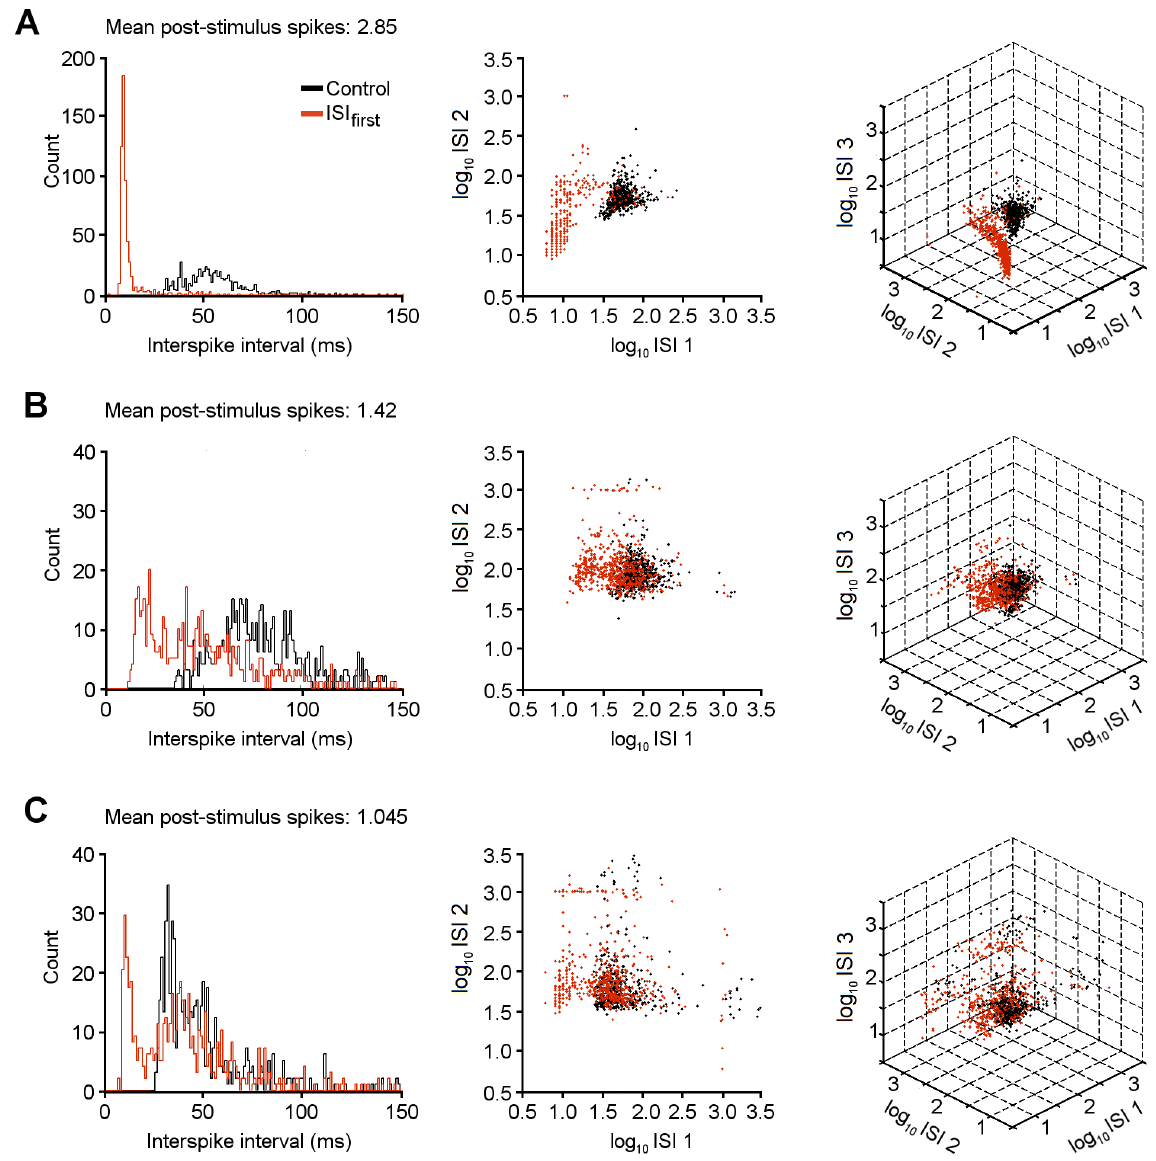
Figure 8. Post-stimulus spike train structure. A) Interspike intervals for a cell stimulated at 1 Hz and 25 m A in the molecular layer, with mean post-stimulus spike number of 2.85. Left panel shows histogram of first ISI (red line) and spontaneous spikes (black line). Middle panel shows a plot of second ISI against first ISI, for post-stimulus spikes (red dots) and spontaneous spikes (black dots). Note that separation between populations is evident on x axis but less so on y axis. Right panel shows plot of third ISI, against second and first ISIs. Again, no separation is evident on third axis. B) Similar plots to panel A, for cell with mean post-stimulus spike number of 1.42. C) Similar plots to panels A and B for cell with mean 1.045. Note there is no clear clustering of evoked spikes in B or C that would allow stimulus-specific spike patterns to be distinguished from spontaneous